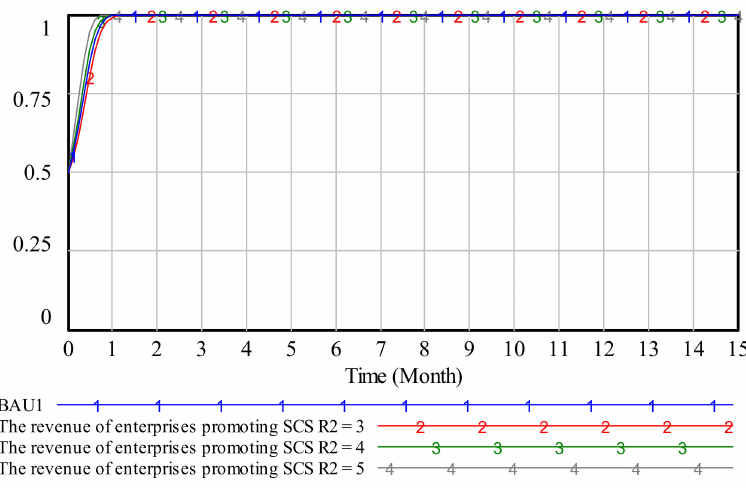
Figure 15. Impact of R 2 on project strategy selection in the BAU1